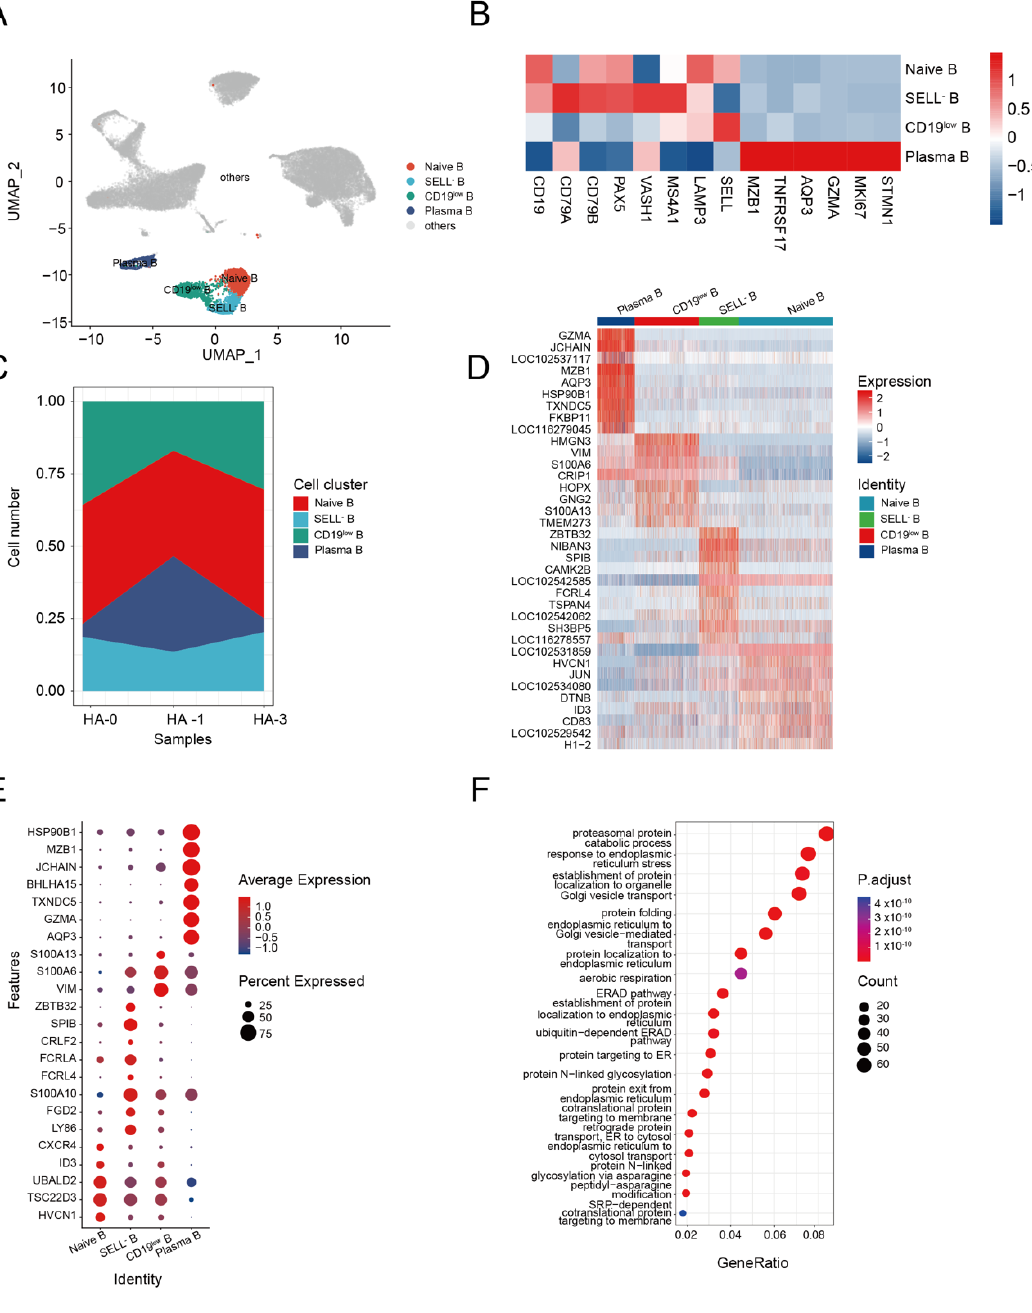
Figure 3. Dynamic changes in functional status among B cell subsets. ( A ) UMAP plot shows the results of sub-clustering of B cells. ( B ) Heatmap shows representative marker expression patterns, annotating clusters to related B cell types. ( C ) Dynamic changes of B cell proportions were identified two times after immunization. ( D ) Heatmap shows differential gene expression patterns in various B cell types. ( E ) Dotplot shows the marker gene expressions pattern in various clusters. ( F ) Representative GO terms and pathways enriched in DEGs of plasma B cell subsets of PBMC.